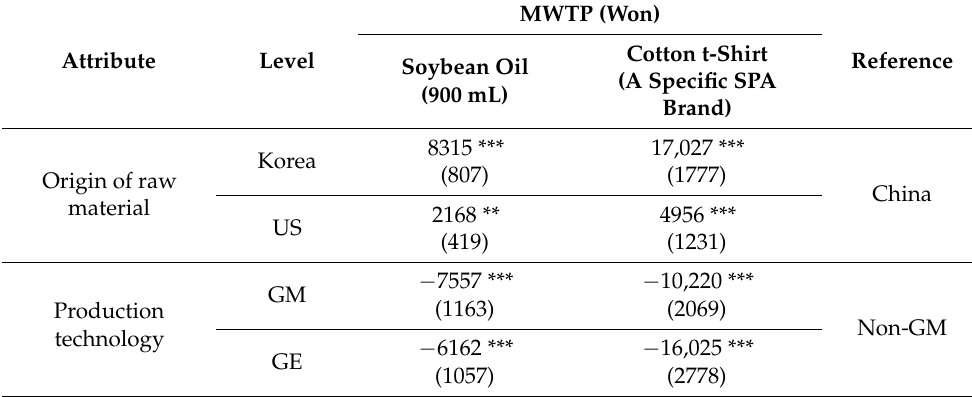
Table 8. MWTP by an attribute